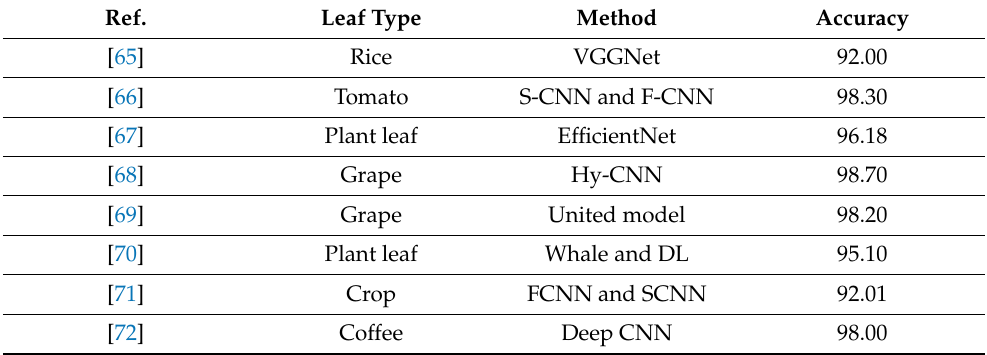
Table 3. Summary of different DL methods for classifying plant